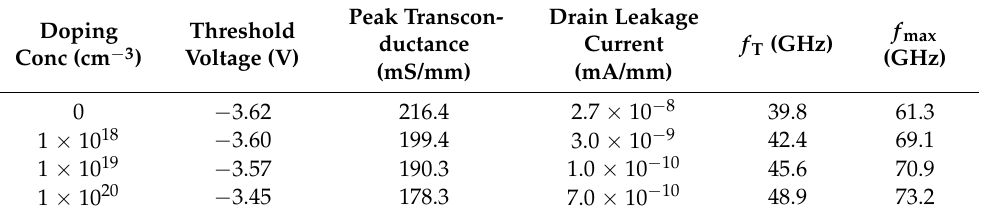
Figure 7. ( a ) Electron concentrations and ( b ) conduction band distributions of HEMT with different doping concentrations of AlGaN buffer layer.